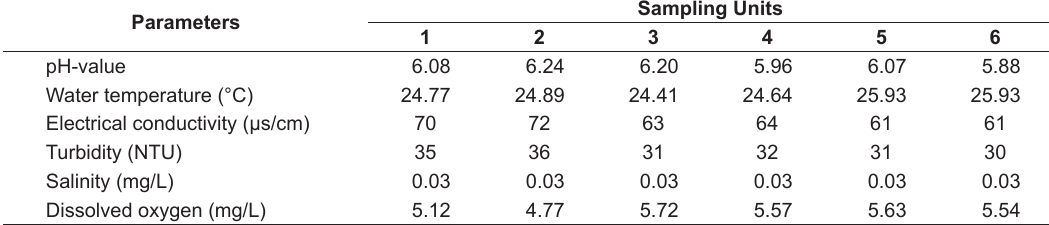
Table 3. Abiotic variables values collected with measurer multi-parameter in six sampling units, it occurs